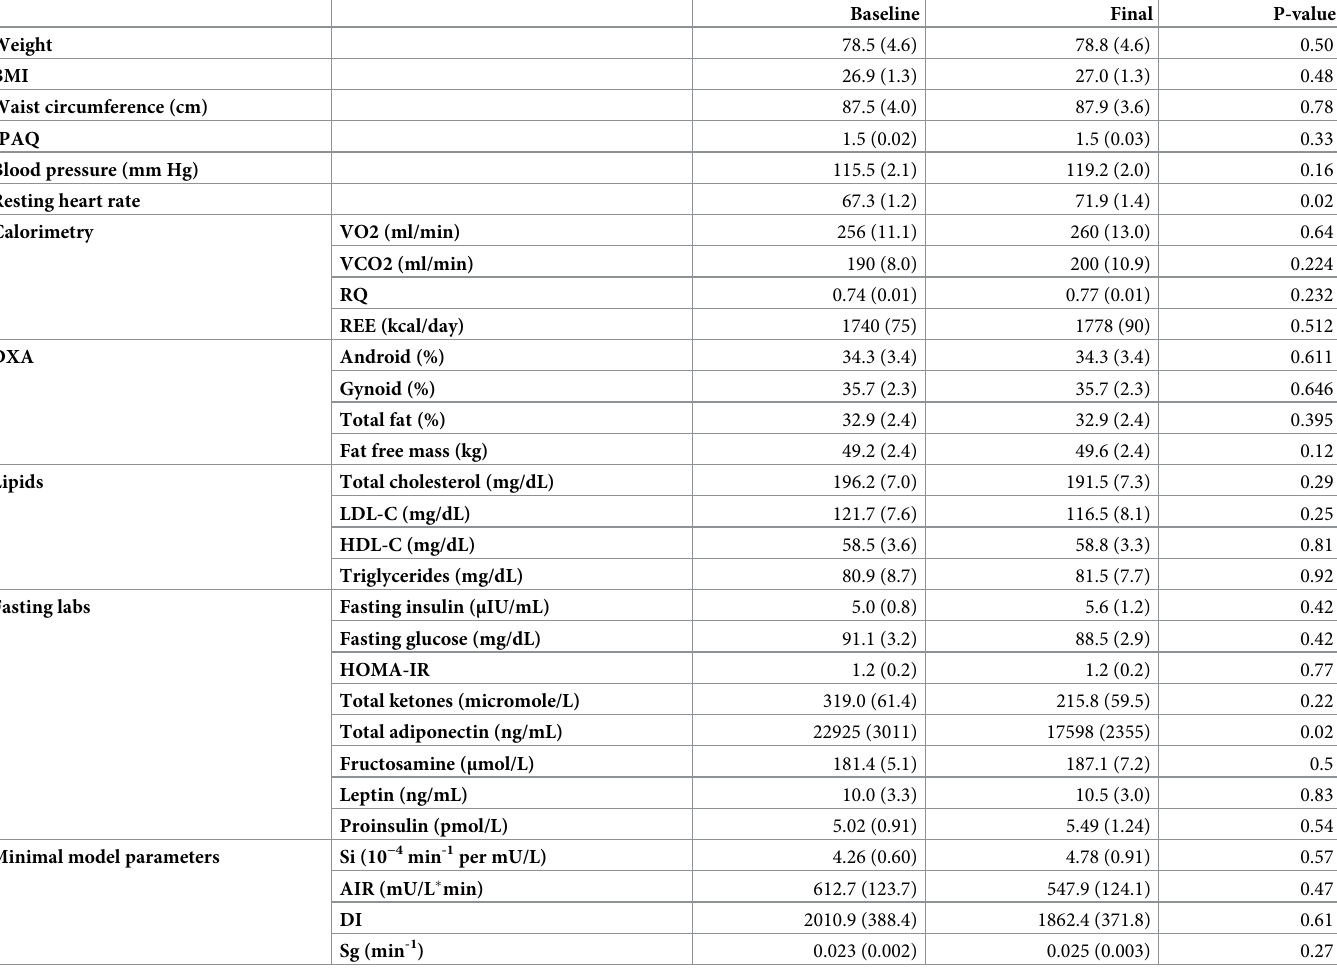
Table 2. Changes in calorimetry, dual x-ray absorptiometry, lipids, labs, and minimal model parameters following 6 weeks of medium chain triglyceride oil supple- mentation (n = 21).